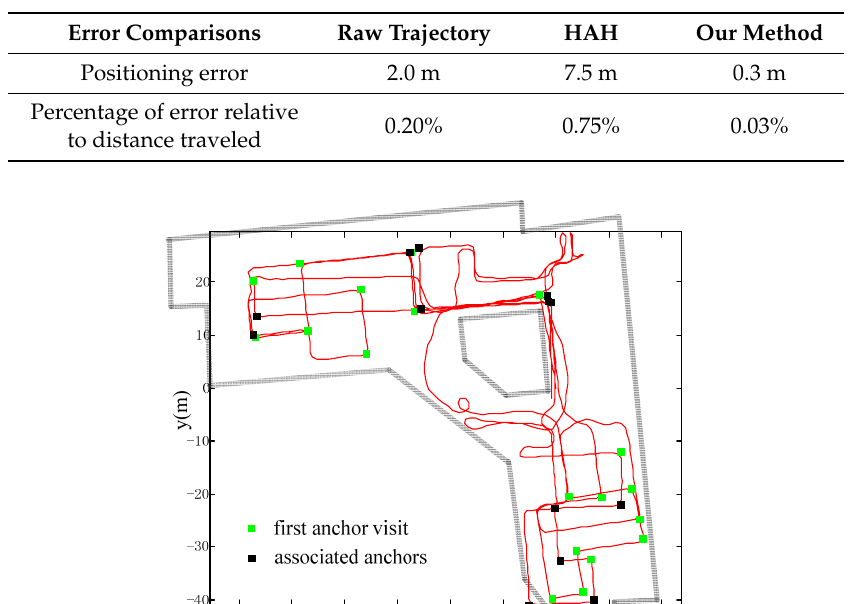
Figure 16. Raw trajectory and extracted anchors. The trajectory is designed to have intensive extracted anchors to test the robustness of the method when wrong anchor association is unavoidable.